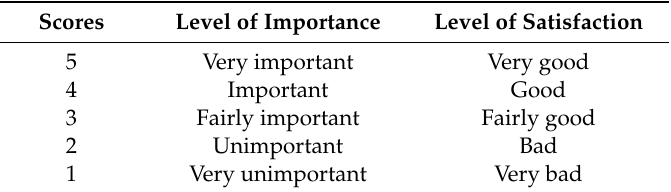
Table 2. Scores of Importance and Satisfaction.